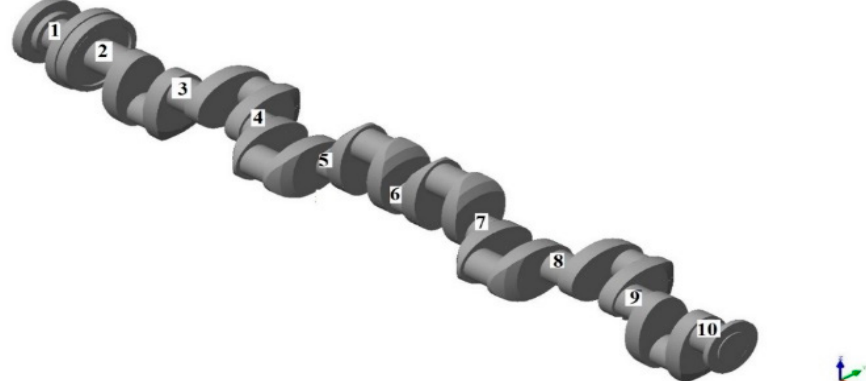
Figure 2. Geometrical model of the analyzed shaft with journal numeration.